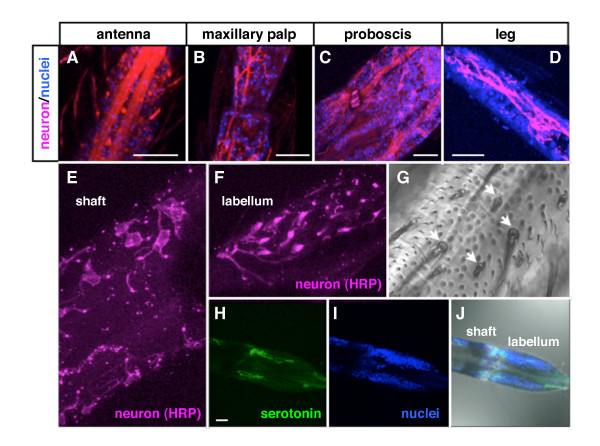
Histological similarity between proboscis and other appendages. (A-D) Distribution of neurons in four different types of mosquito appendages. Panels represent the merged images of immunostaining of antenna (A), maxillary palps (B), proboscis (C), and leg (D) (blue: nuclei, magenta: HRP-positive neuron). Note the similar large bundles of nerve fibers visualized in each appendage. (E-J) A variety of neurons in mosquitoes' proboscis. Panels represent the localization of HRP-positive neurons (magenta) in the shaft (E) and labellum (F) of the proboscis. The proboscis also contains serotonin-positive neurons (blue: nuclei, green: serotonin) (H-J). Note that there are many sensilla (extra sensory organs) distributed throughout the proboscis (G). All bars: 25 μm.